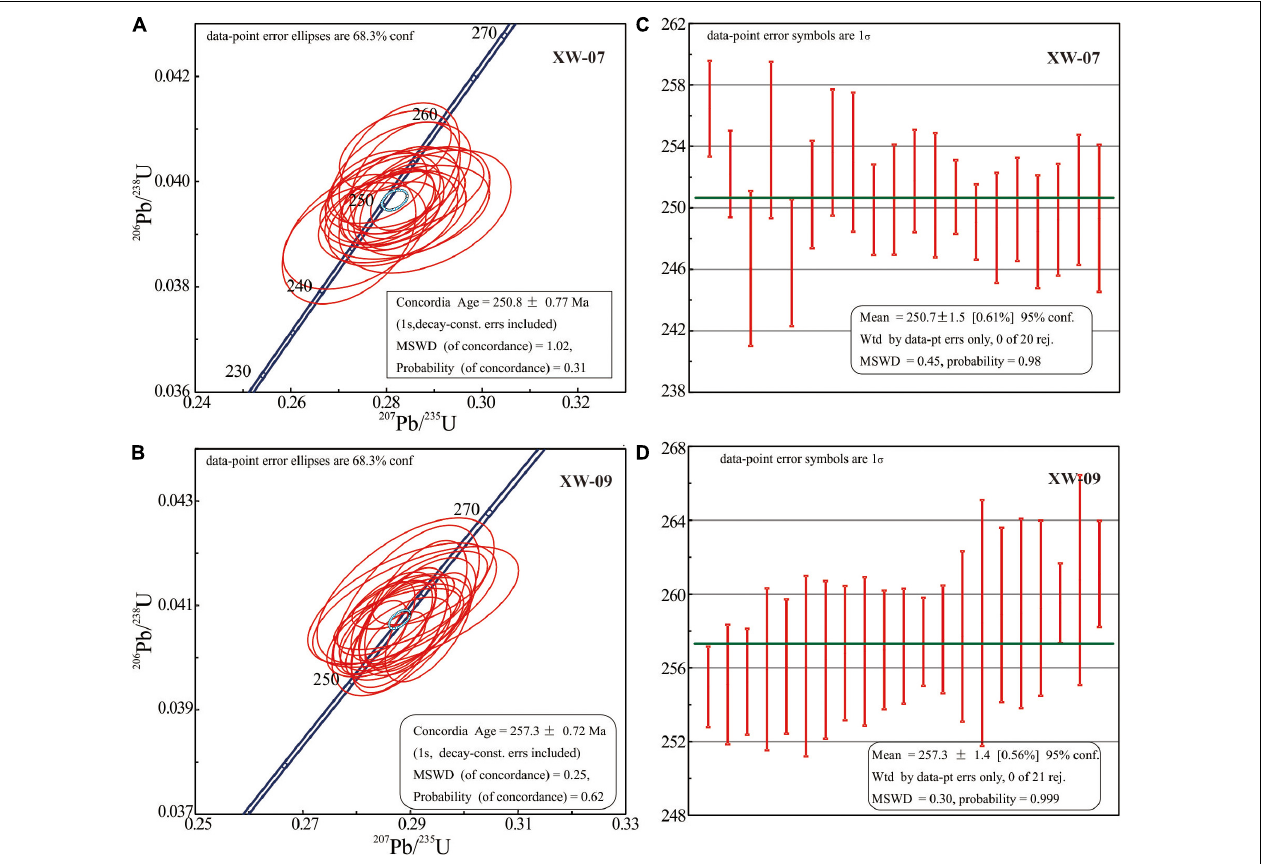
FIGURE 5 | Zircon U–Pb age diagrams of gabbros (A,C) and olivine-pyroxenites (B,D) in the Xiwanggou mafic–ultramafic